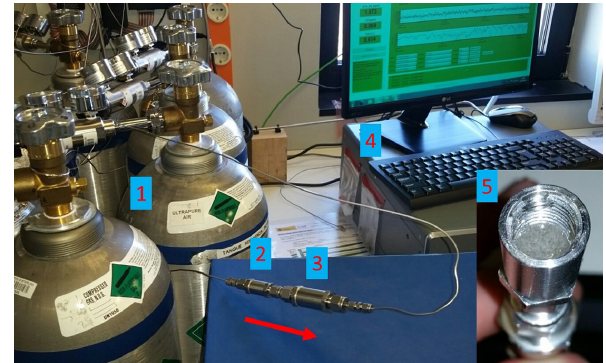
Figure 8. Experimental setup used for the water-droplet test per- formed on IZO CRDS G2401. (1) Cylinders containing dry natural air (the red arrow shows the flow direction); (2) stainless steel filter housing containing crushed silica gel balls (see details of the in- terior in 5) soaked with deionized water; (3) stainless steel 0.5µm filter; and (4)